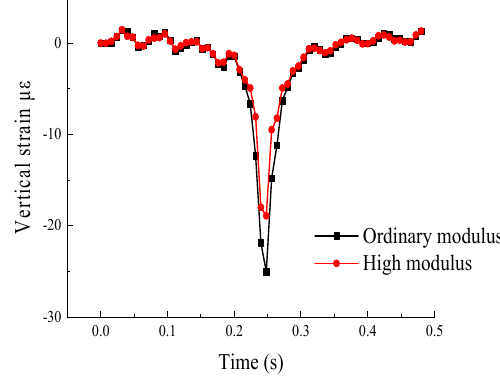
Figure 5. Comparison of vertical strain in the upper surface layer.